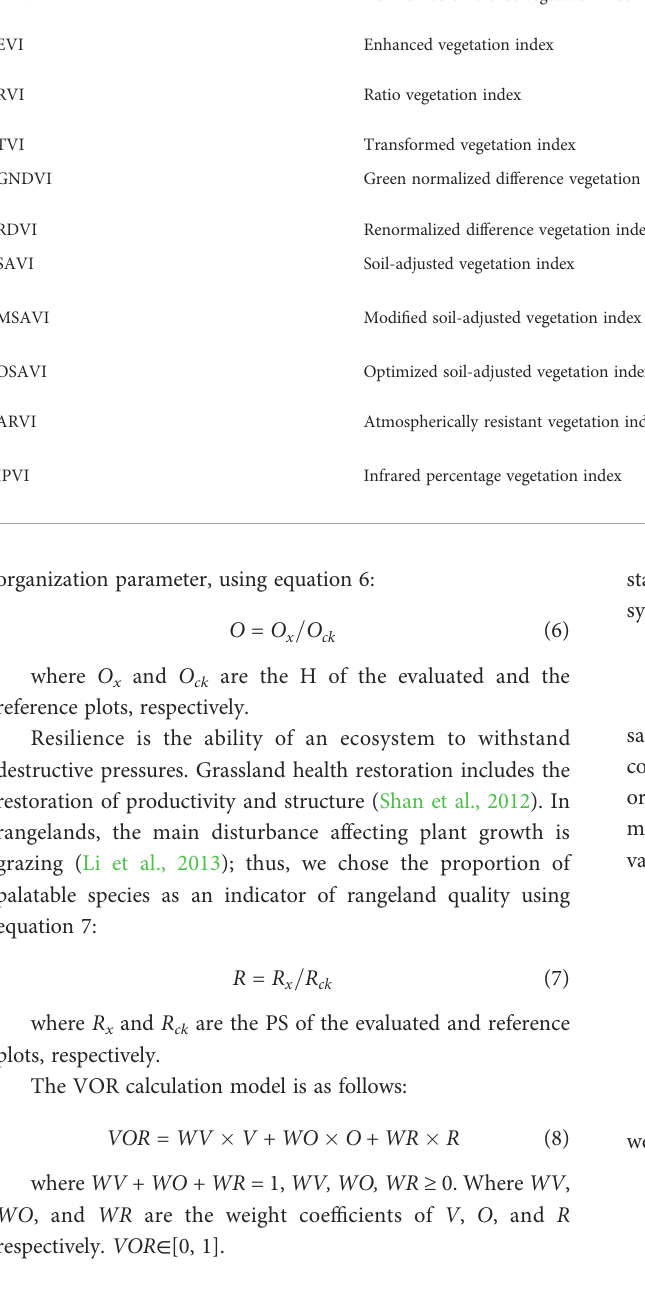
ffiffiffiffiffiffiffiffiffiffiffiffiffiffiffiffiffiffiffiffiffiffiffiffiffiffi NDVI (cid:1) RVI